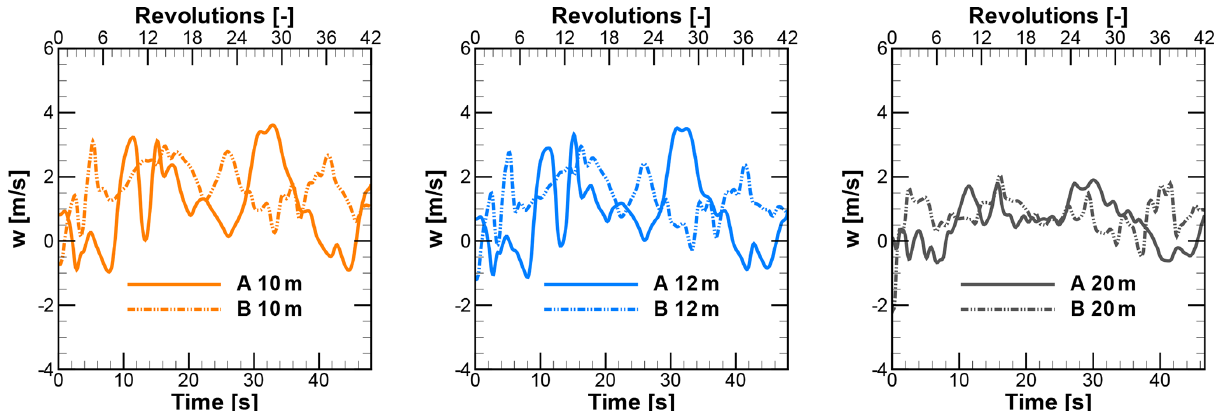
Figure 13. Time series of w component of velocities at different rooftop heights above building A and